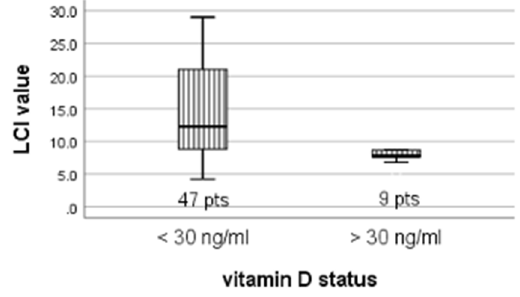
Figure 1. LCI variation according to vitamin D status.